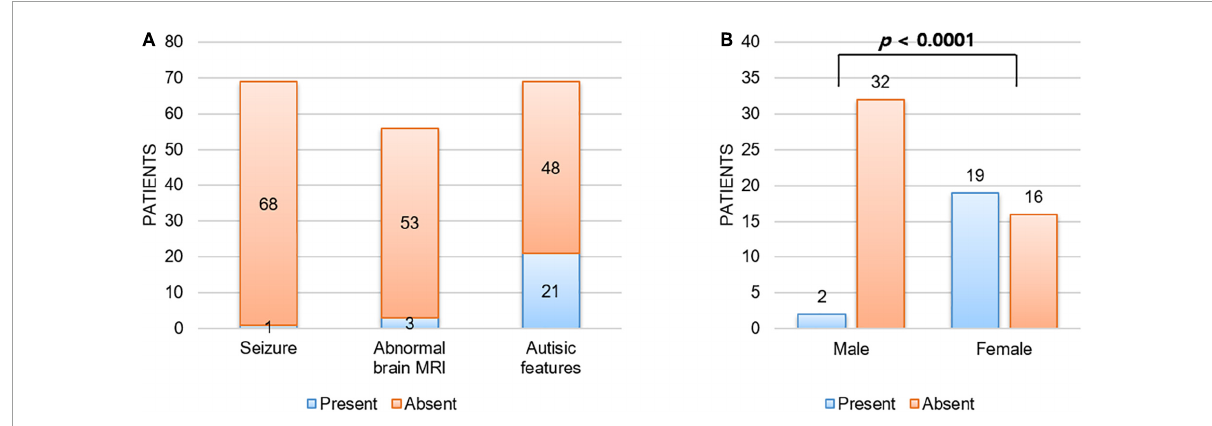
FIGURE2 Unique clinical manifestations of CTNNB1 -related neurodevelopmental disorder. (A) Patients with CTNNB1 -related neurodevelopmental disorder were less likely to have seizure (1.4%) or structural brain abnormality (5.4%), and autistic features were shown in 30.4% of patients. Here we considered three patients with borderline brain MRI findings (delayed bilateral frontal lobe myelination, mild corpus callosum thinning, and mild dilation of ventricles) as normal. In addition, abnormal brain MRI findings noted in two patients out of three also did not suggest obvious structural abnormality (left temporal lobe atrophy and hypoplasia of corpus callosum). (B) Autistic features were significantly more frequent in female patients than in male patients. Fisher’s exact test was used to compare frequency of autistic features by